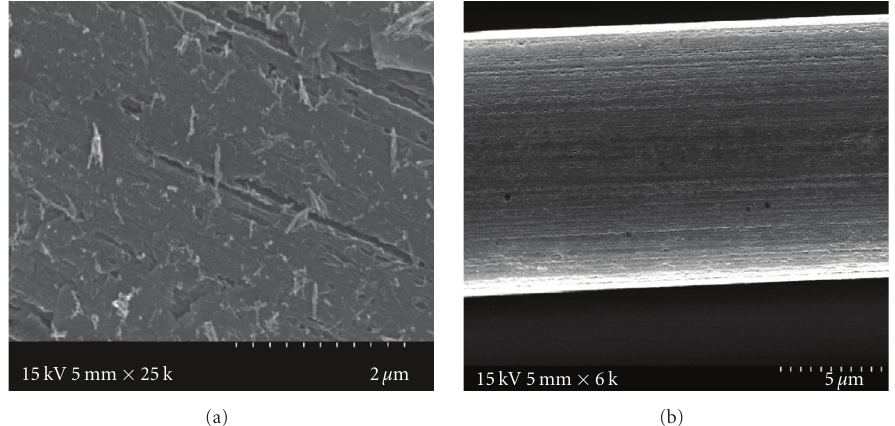
Figure 1: (a) SEM image of carbon fiber annealed at 500 ◦ C to remove sizing, (b) SEM image of carbon fiber cleaned by acetone and ethanol.